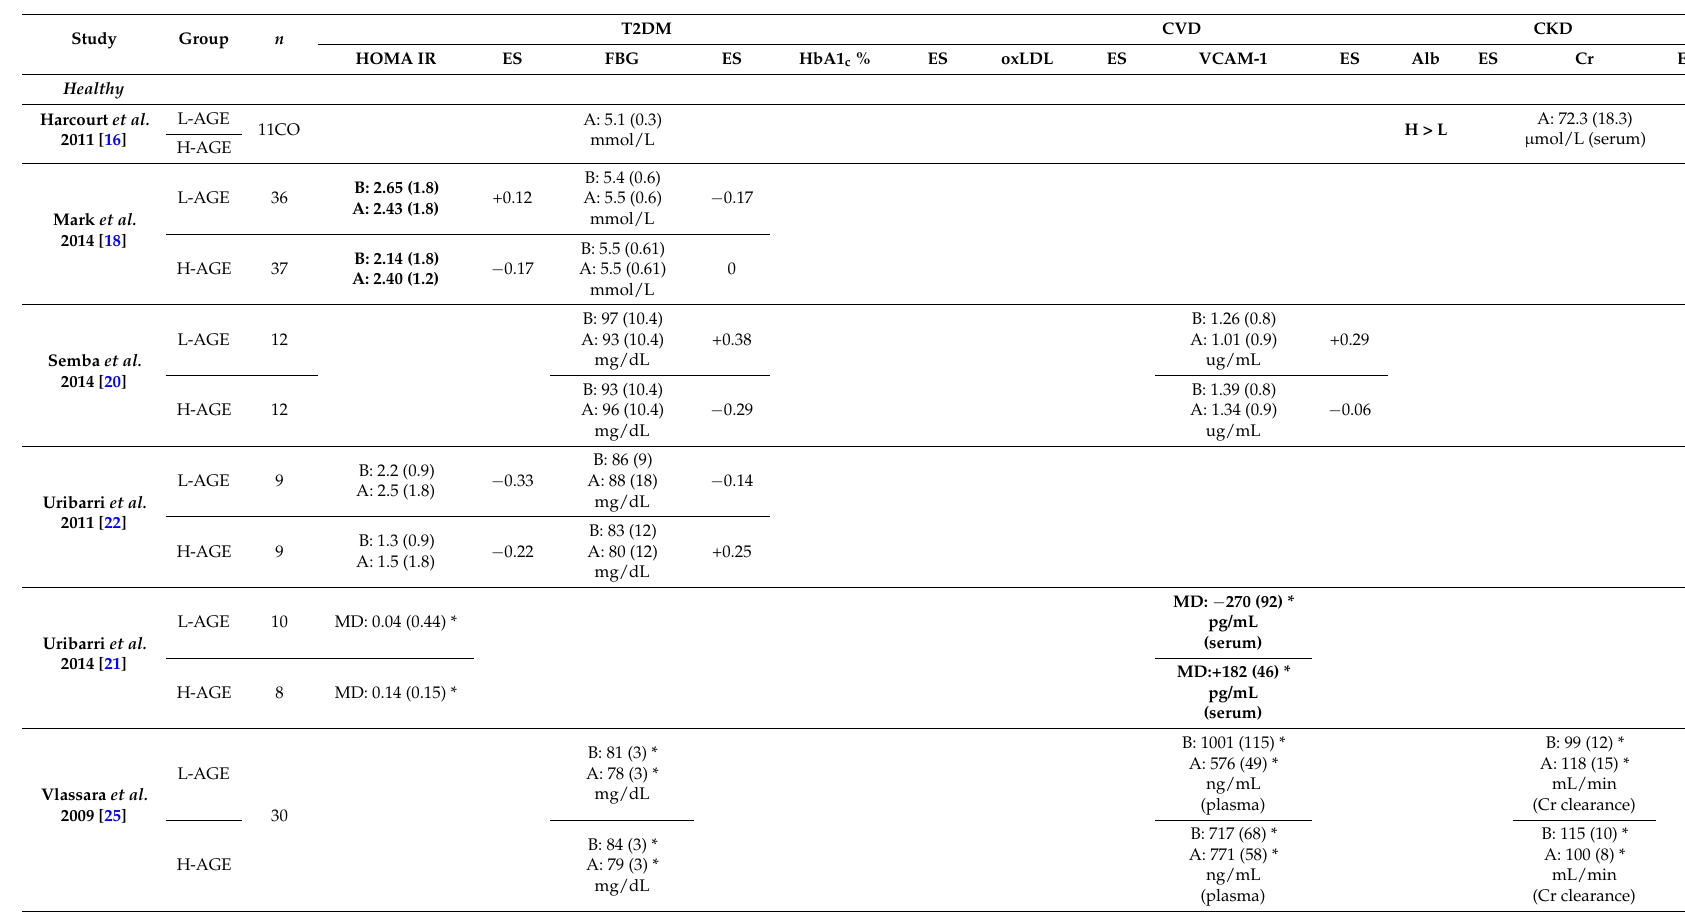
Table 3. Biomarkers of chronic disease